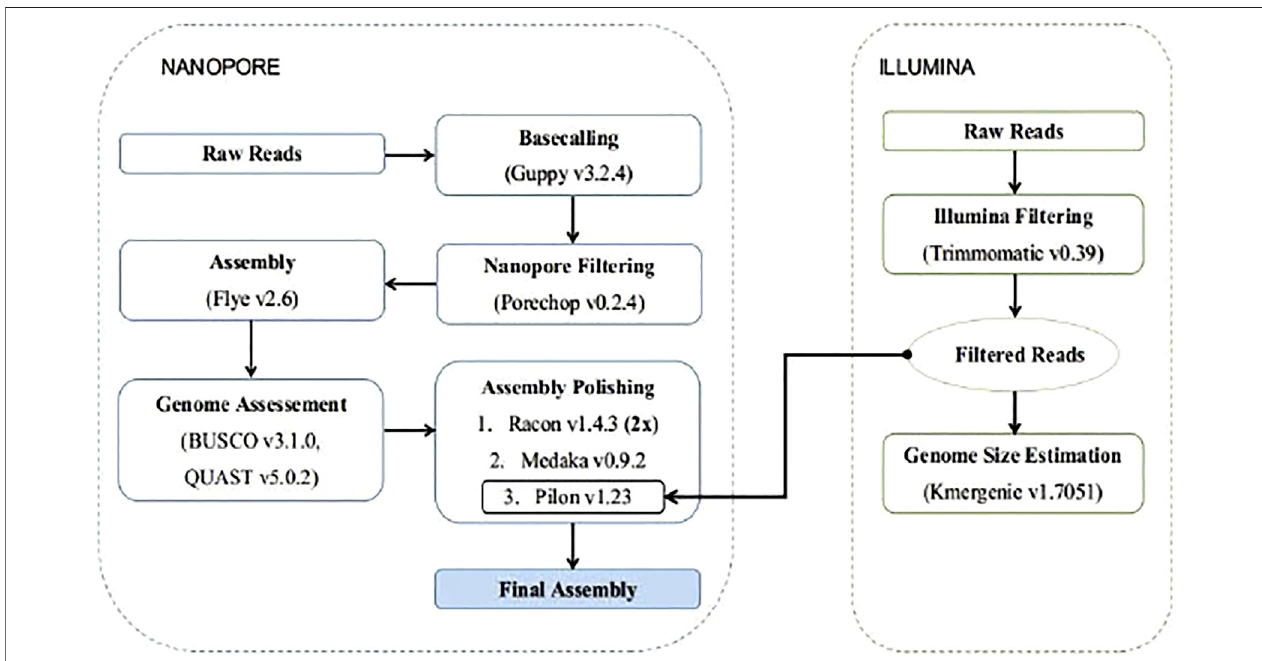
FIGURE 1 | Lagocephalus sceleratus genome assembly